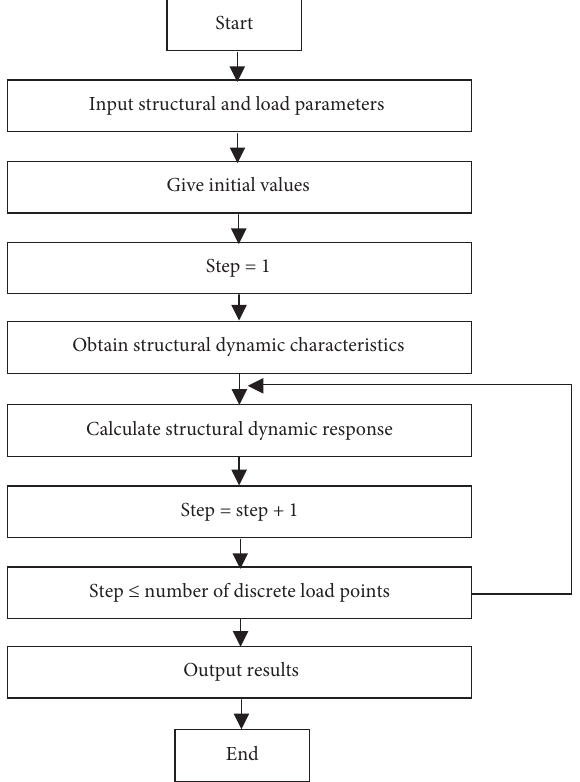
Figure 5: Flowchart of the elastic time-history analysis